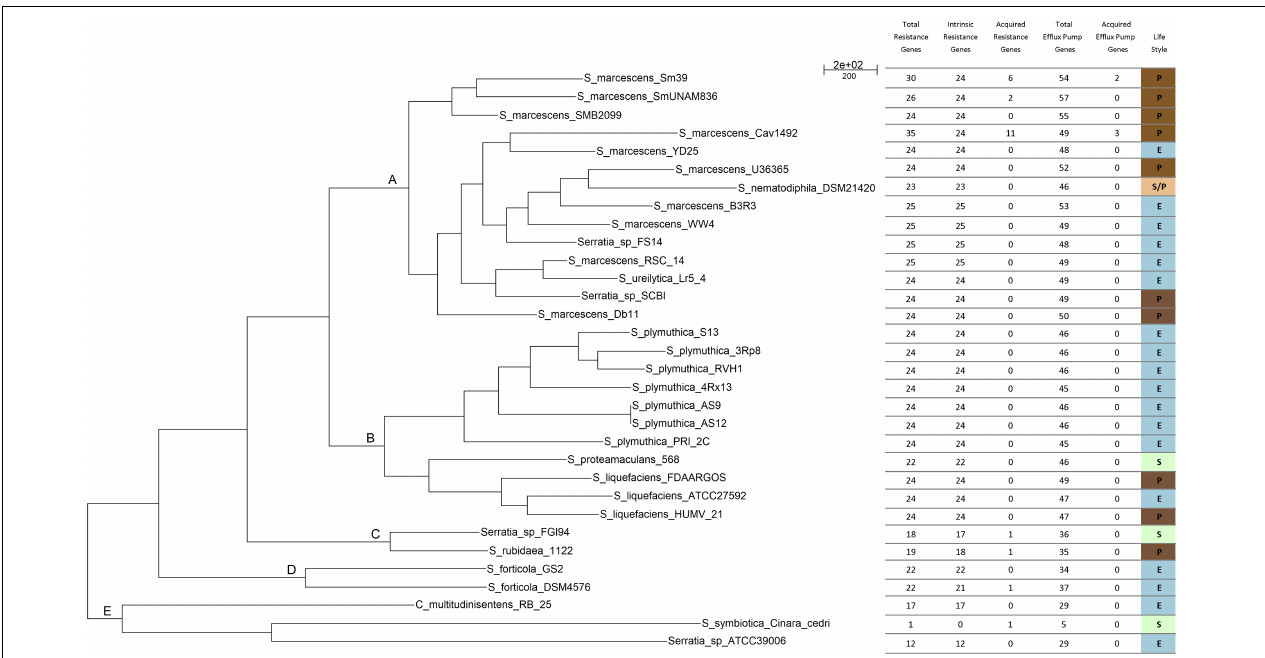
FIGURE 2 | Parsimony pan-genome tree for 32 Serratia genomes derived from presence/absence of homolog genes in a consensus pan-genome matrix computed by the COGtriangles y OrthoMCL clustering algorithms. This phylogeny was the most parsimonious tree found in a tree search made with PARS from the PHYLIP suite. The tree has a total length of 20,453 steps. Capital letters A-E indicate the phylogenetic groups.